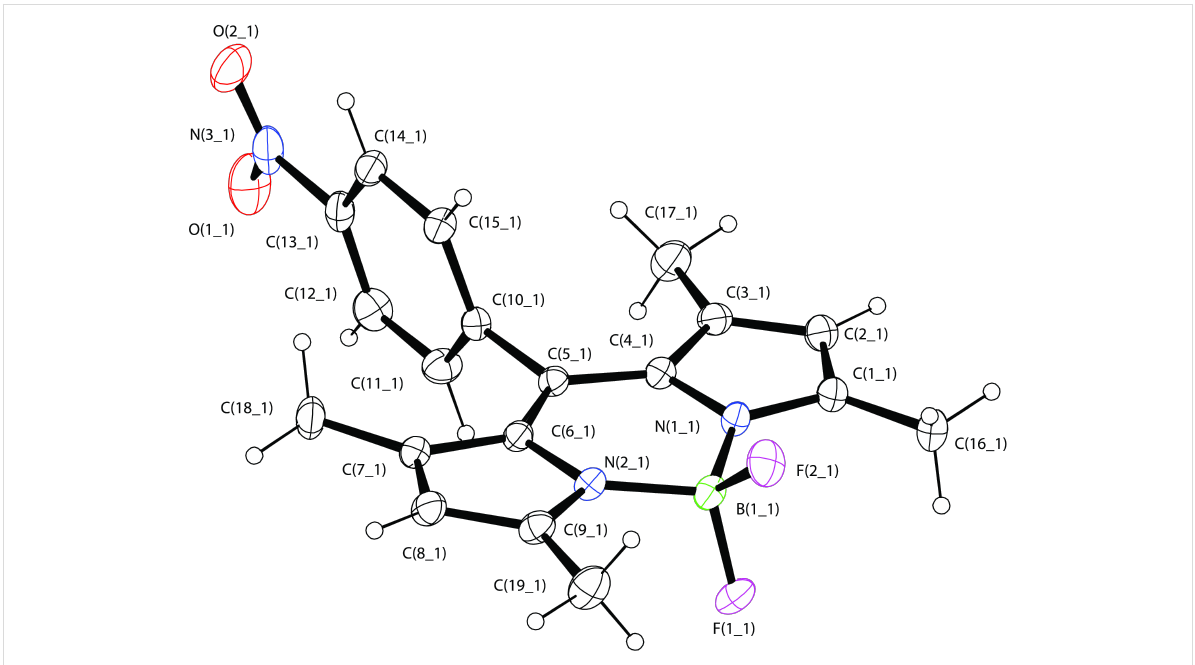
Figure 1: An ORTEP plot of nitro- F -BODIPY 8 at the 50% probability level. A CIF file for the structure determination is available as Supporting Infor- mation File 2 and is also available on request from the Cambridge Crystallographic Data Centre as deposition